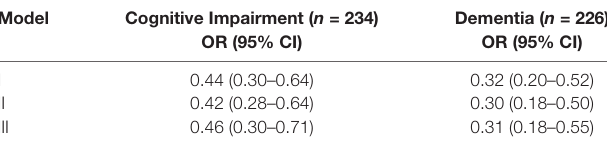
TABLE 3 | Odds ratio for association of abdominal visceral fat with cognitive impairment (CDR ≥ 0.5) and dementia (CDR ≥ 1). Model Cognitive Impairment ( n = 234)